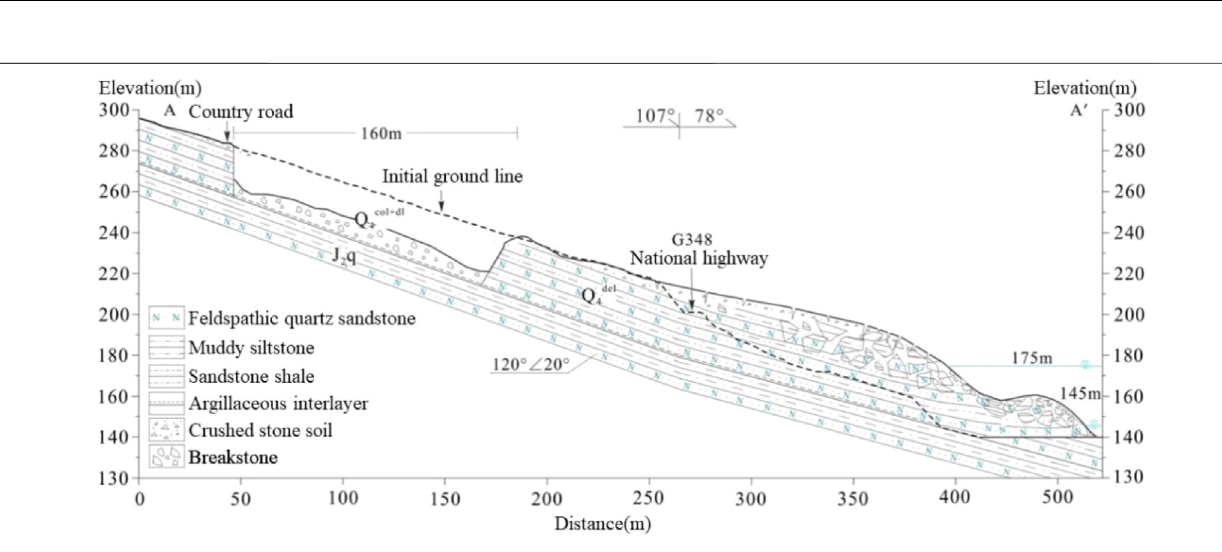
FIGURE 4 | Geological pro fi le of the main slip zone (A-A ′